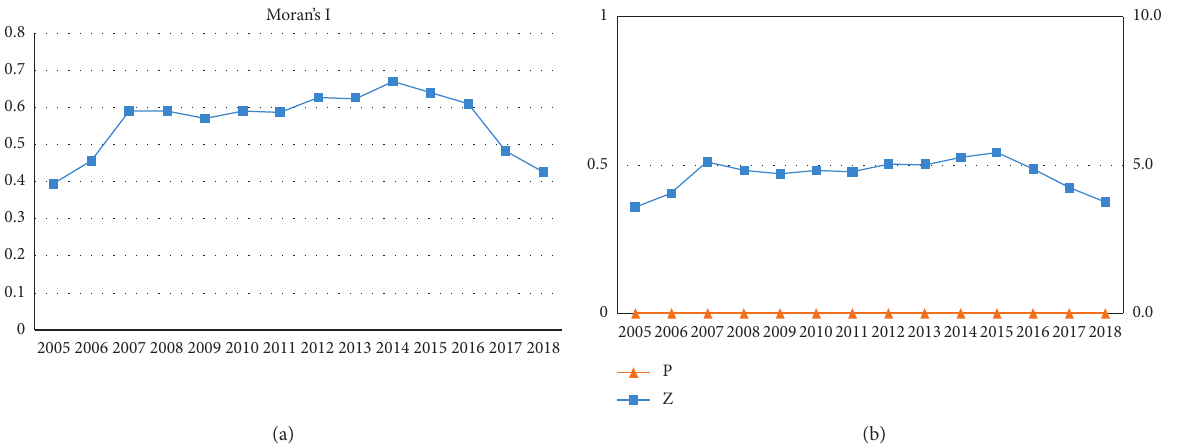
Figure 7: Analysis on the overall correlation of comprehensive competitiveness of Table 4: Changes in Moran scatter diagram of competitiveness of Huaihe eco-economic city. Quadrant